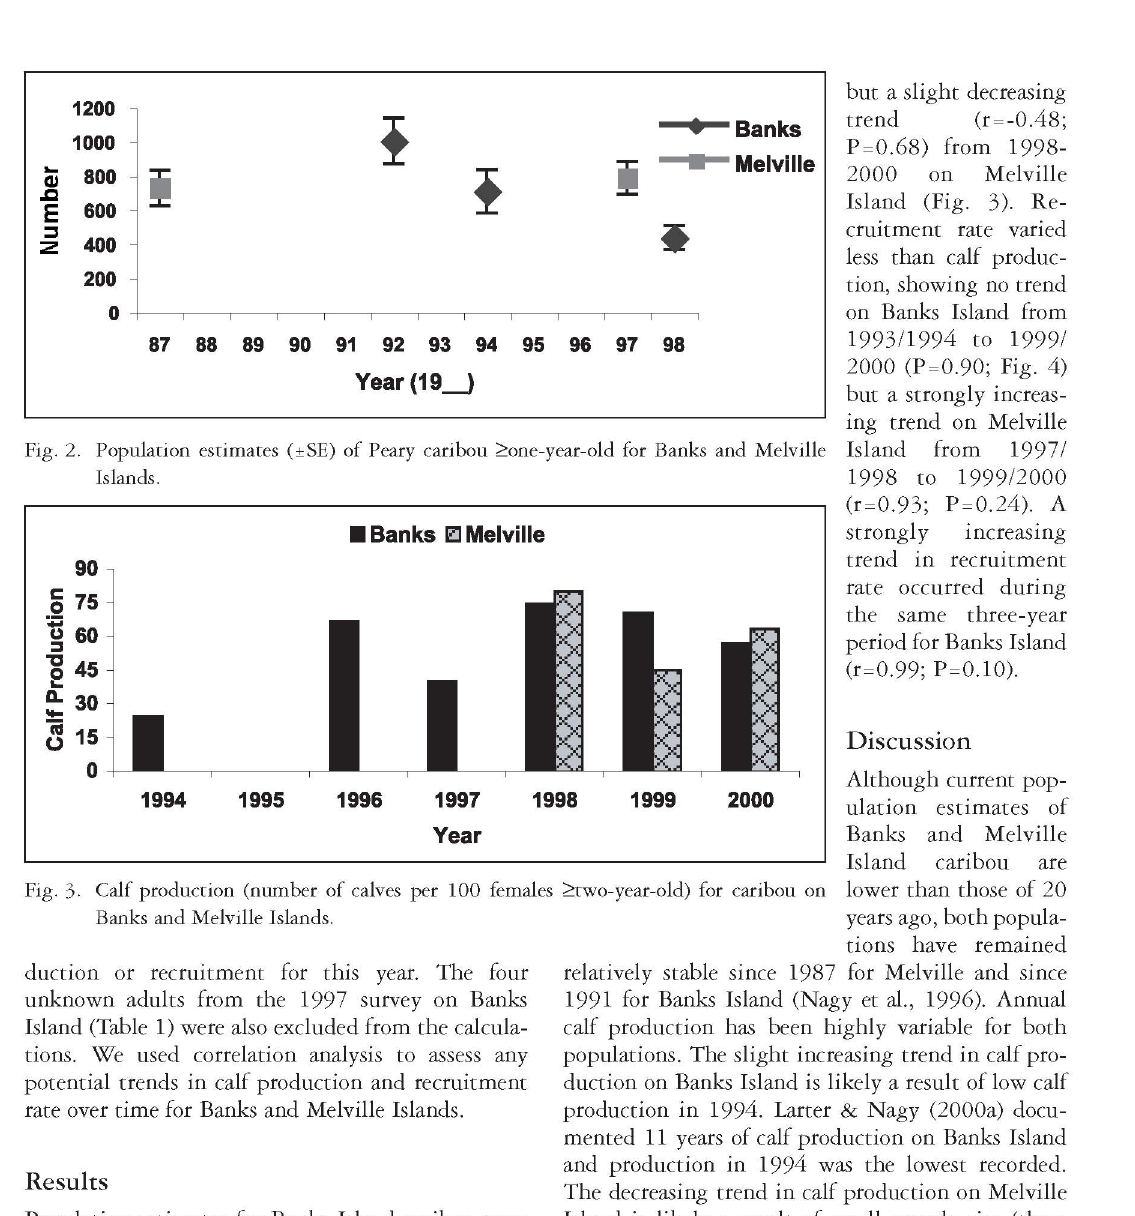
Fig. 2. Population estimates (±SE) of Peary caribou >one-year-old for Banks and Melville Islands.